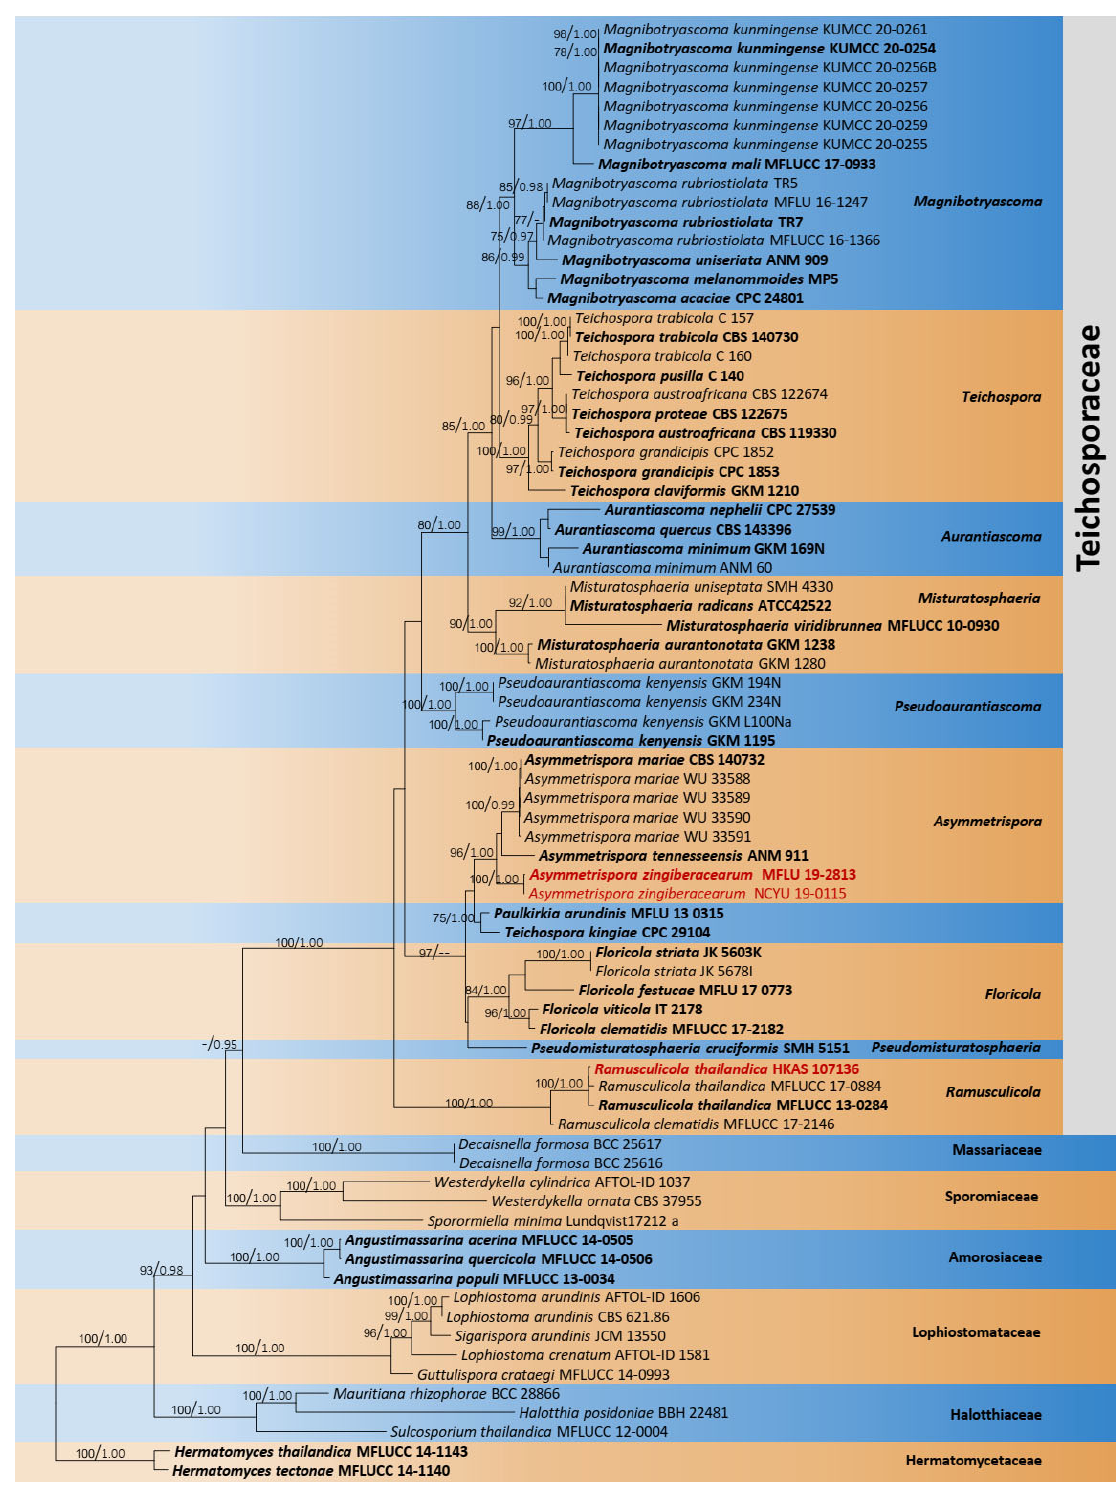
Figure 4. Phylogram generated from maximum likelihood analysis is based on combined LSU, ITS, SSU, tef1 ‐α , and rpb2 sequence data. Related sequences of Teichosporaceae were obtained from Tennakoon et al. [37]. ML bootstrap values equal to or greater than 75% and Bayesian posterior probabilities (BYPP) equal to or greater than 0.95 are indicated above the branches. The tree was rooted to Hermatomyces tectonae (MFLUCC 14 ‐ 1140) and H. thailandica (MFLUCC 14 ‐ 1143). The newly generated sequences are indicated in red. Type and ex ‐ type strains are in bold.